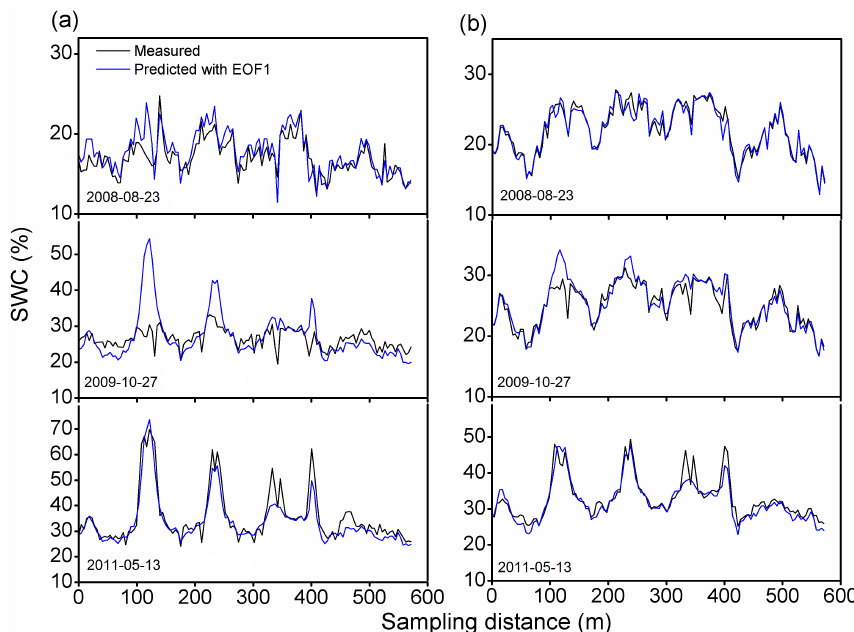
Figure 7. Estimated soil water content (SWC) versus measured SWC for three dates at different soil water conditions (23 August 2008, 27 October 2009, and 13 May 2011 are associated with relatively dry, medium, and wet days, respectively) using the TA model for (a) 0–0.2 and (b) 0–1.0m.